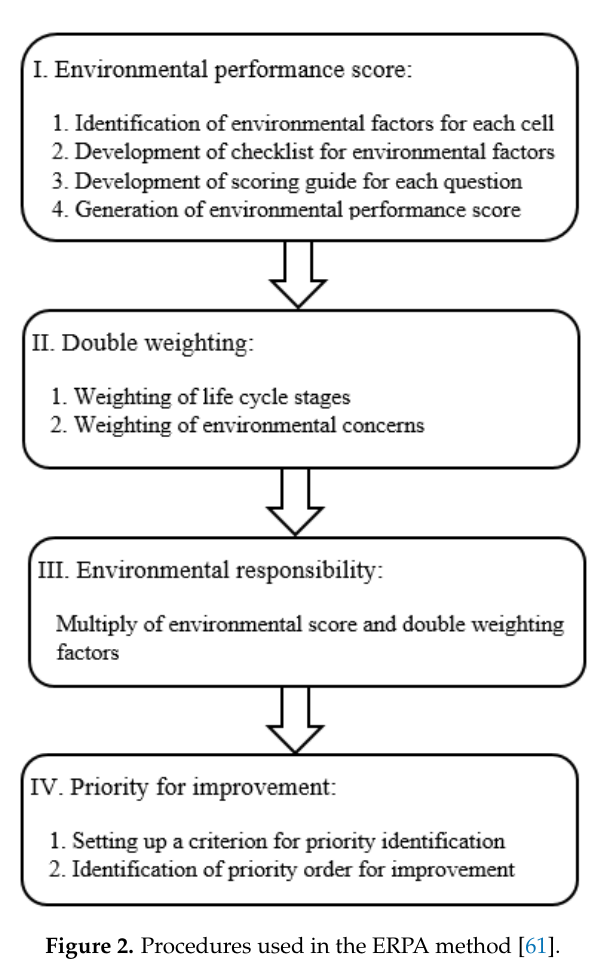
Figure 2. Procedures used in the ERPA method [61].